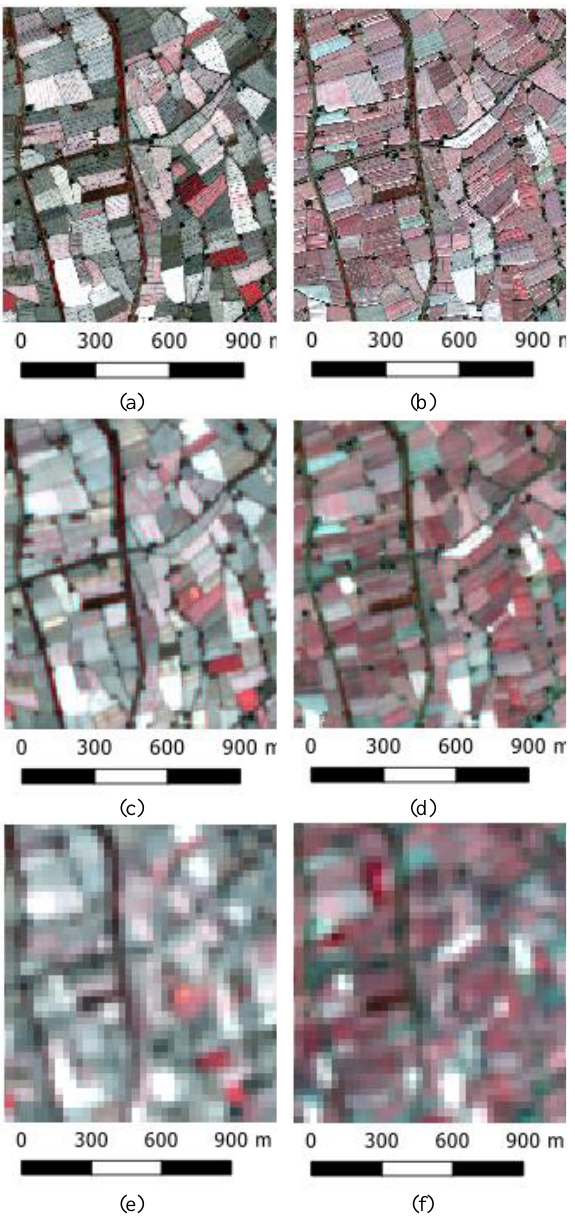
Figure 10 . False-colour satellite images: (a) WV3 July 11; (b) WV3 December 26; (c) S2 July 12; (d) S2 December 24; e) L8 July 11; (f) L8 December 29.